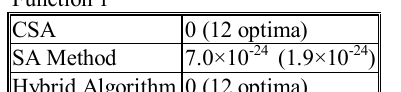
Table 2. Performance comparisons of three optimization methods in benchmark functions with different dimensions (optima ± standard error).